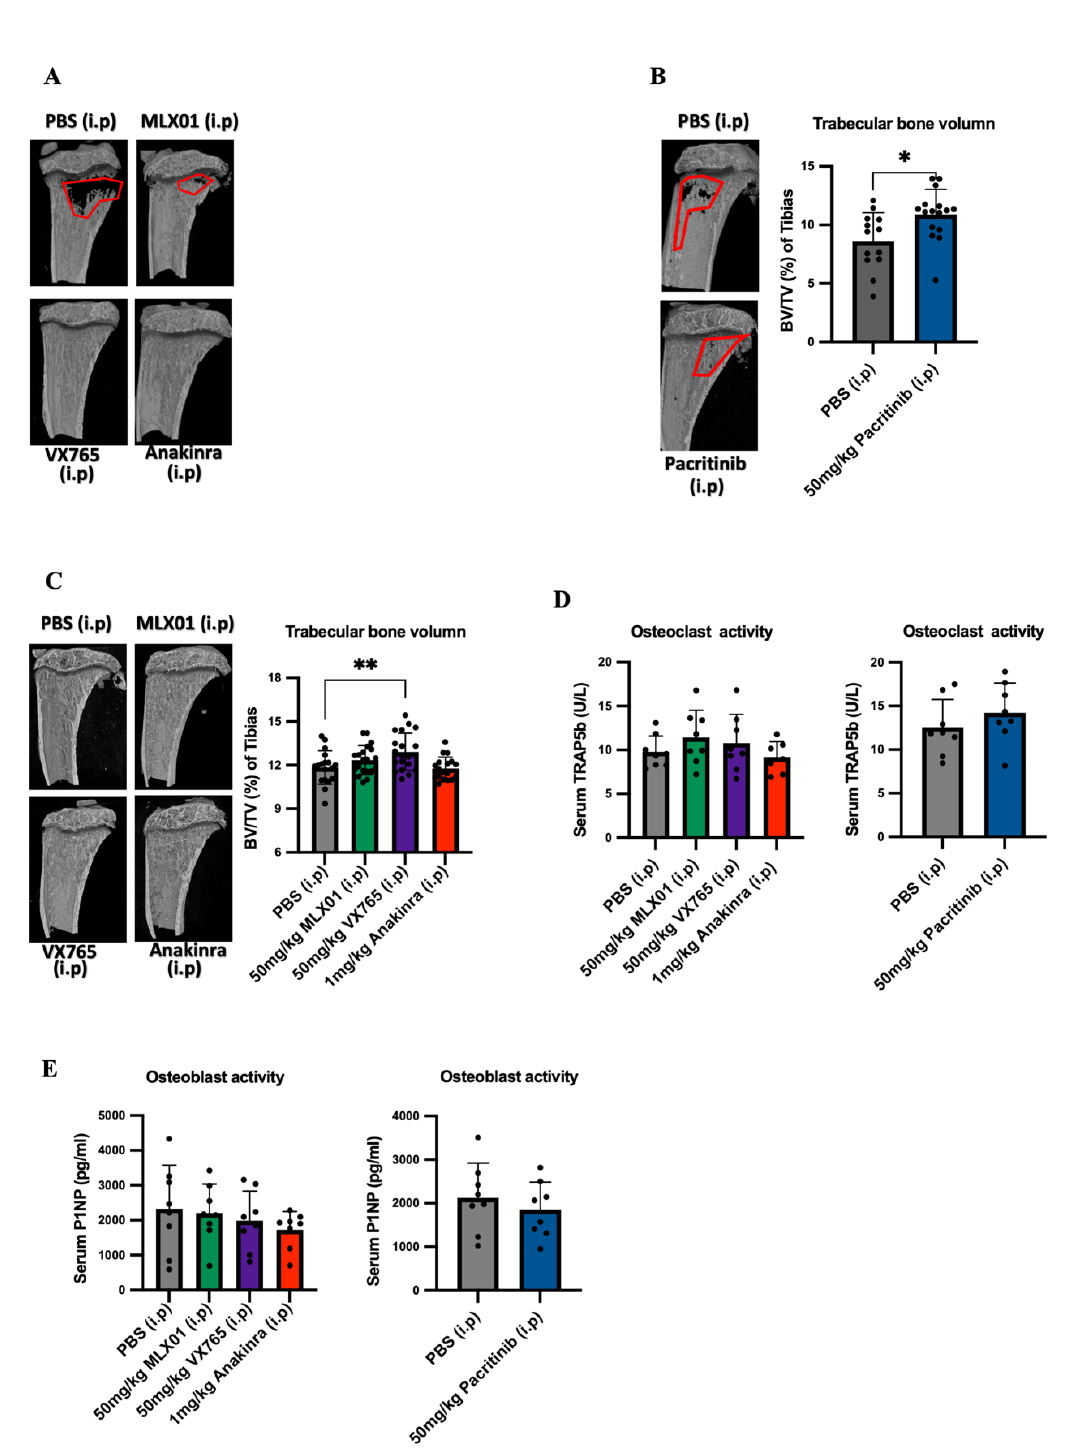
Figure 5. Effects of inhibiting IL1β, IL1R1, Caspase -1 and IRAK1 on bone turnover and volume ( A ) Bone volume/tissue volume (BV/TV) % of trabecular bone in the mouse tibia following dissemina- tion of E0771 cells in this site and 13 consecutive daily treatments with PBS (control), MLX01, VX765 or Anakinra (Study Figure 3A) or ( B ) 15 days 15 consecutive daily treatments with Pacritinib (Study Figure 3H). ( C ) Bone volume/tissue volume (BV/TV) % of trabecular bone in mouse tibia following orthotopic injection of E0771 and consecutive daily treatments with PBS (control), MLX01, VX765 or Anakinra until primary tumour reached 1000 mm 3 . ( D , E ) ELISA analysis of TRAP5b ( D ) or P1NP ( E ) in mouse serum following dissemination of E0771 cells and 13 consecutive daily treatments with MLX01, VX765 or Anakinra (Study Figure 3A) or Pacritinib (Study Figure 3H). Graphs represent mean + SD, * p < 0.05, ** p < 0.01 .